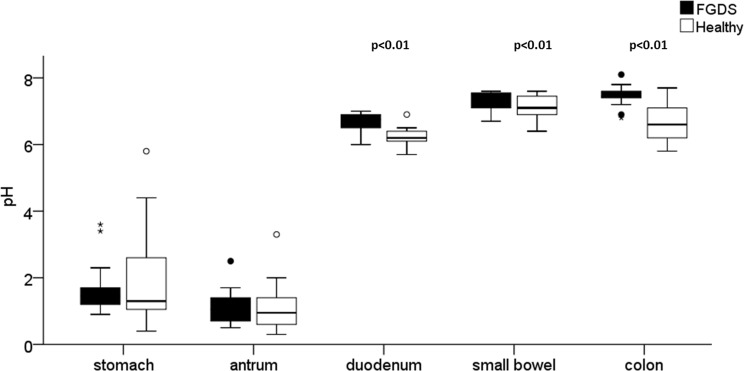
Gastrointestinal pH measurements.Box plots showing the elevated pH values in the duodenum, small bowel and colon found in patients with Familial GUCY2C diarrhea syndrome (FGDS) compared to healthy controls (HC). There was no difference in the stomach and antrum. The median is shown within the box; the box represents the 25 and 75 percentiles and the whiskers 10 and 90 percentiles.